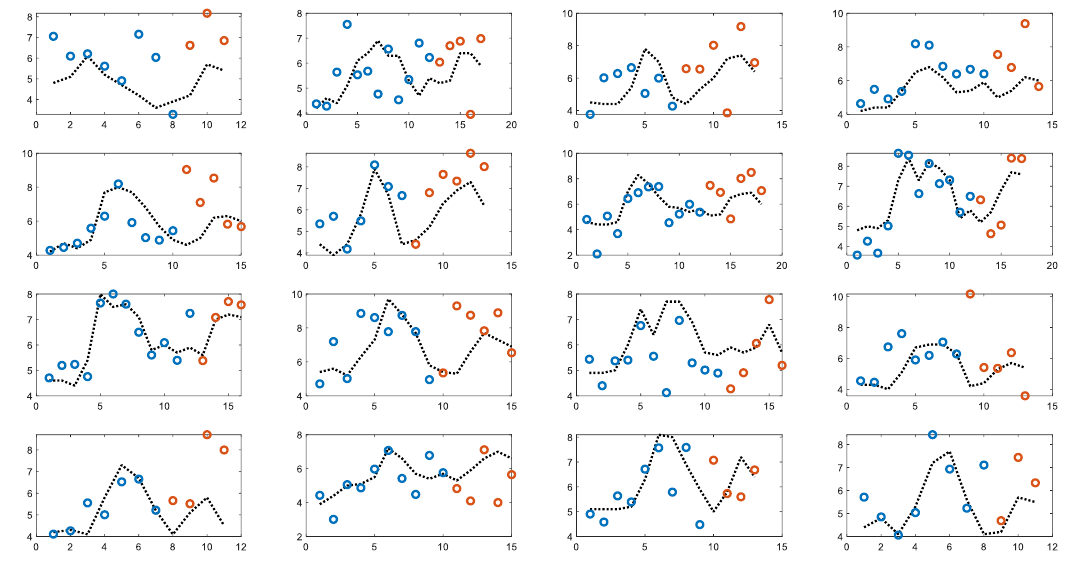
Fig.11: ANN model with one hidden layer and five nodes based on NIR, resistance and reactance. Globally trained until the start of intake of sugar-containing soft drink for the second time (blue dots) and thereafter used for prediction orange